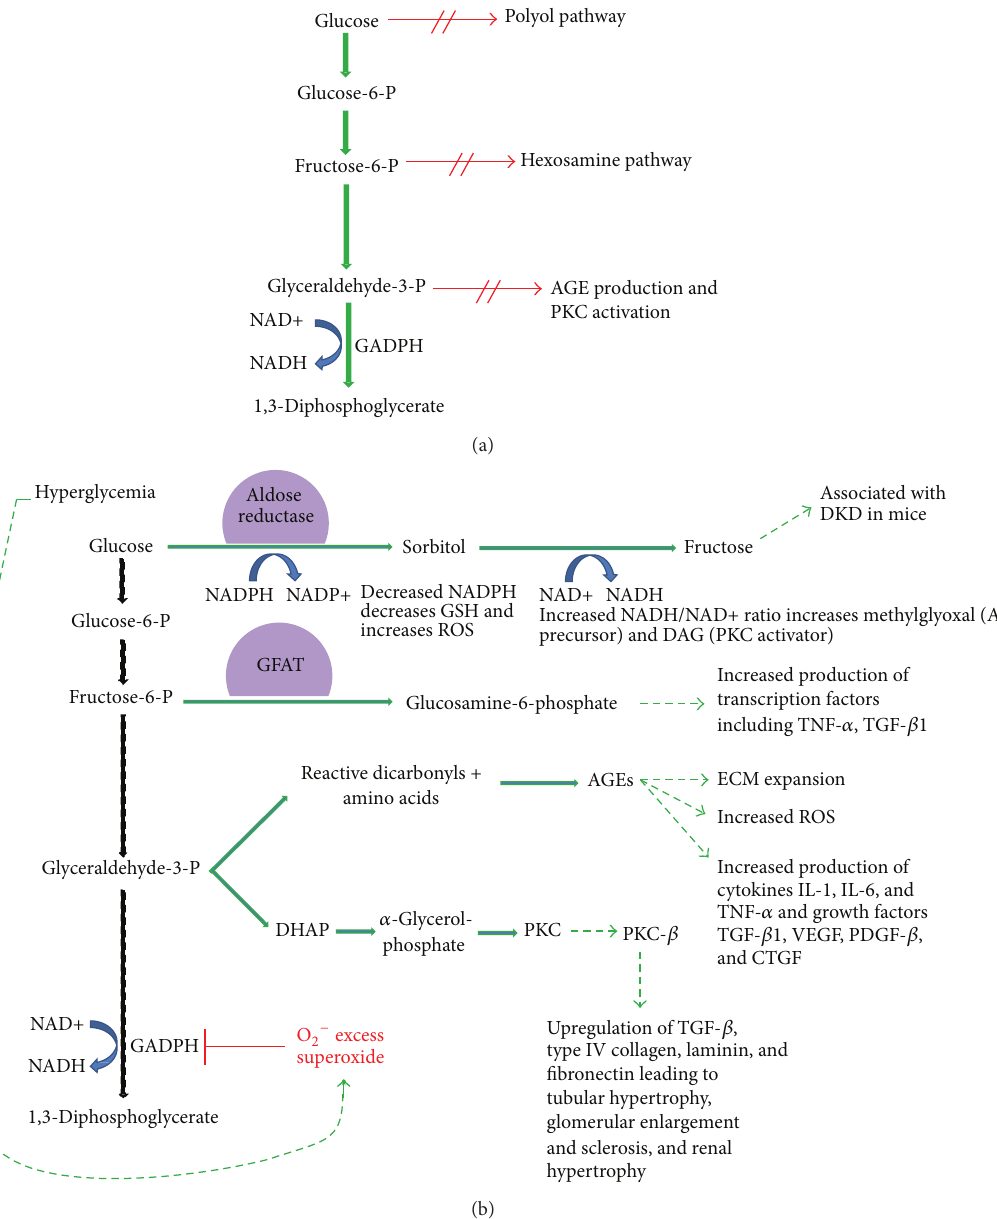
Figure 2: (a) Glycolysis is the biochemical pathway in which glucose is broken down by cells to make energy. In a normoglycemic environment, that is, in patients without diabetes, glycolysis proceeds down its well described path without shunting into the polyol pathway, hexosamine pathway, or pathways that would lead to AGE production or PKC activation. (b) In a hyperglycemic environment, as would be seen in patients with either type 1 or type 2 diabetes, high glucose conditions lead to activation of excess superoxide which then inhibits the enzyme GADPH. This prevents glycolysis from proceeding down its natural course and creates a backlog of glycolysis precursors. Increased levels of glucose upregulate the polyol pathway whereas increased levels of fructose-6-phosphate upregulate the hexosamine pathway. Increased levels of glyceraldehyde-3-phosphate upregulate both AGE precursors and DAG, the latter being a cofactor for PKC